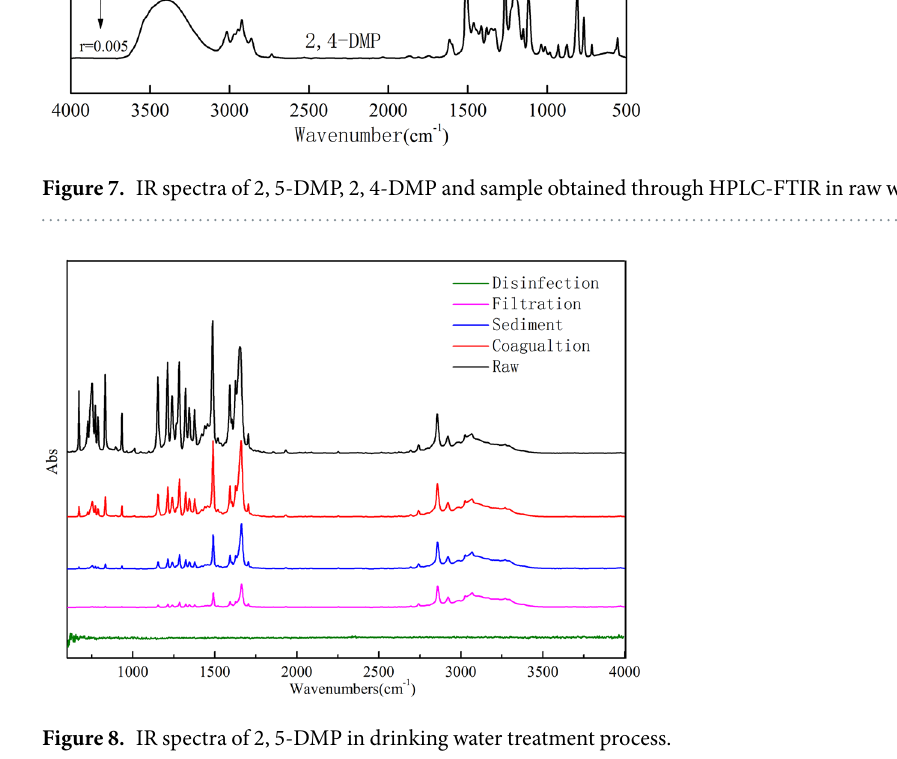
Figure 8. IR spectra of 2, 5-DMP in drinking water treatment